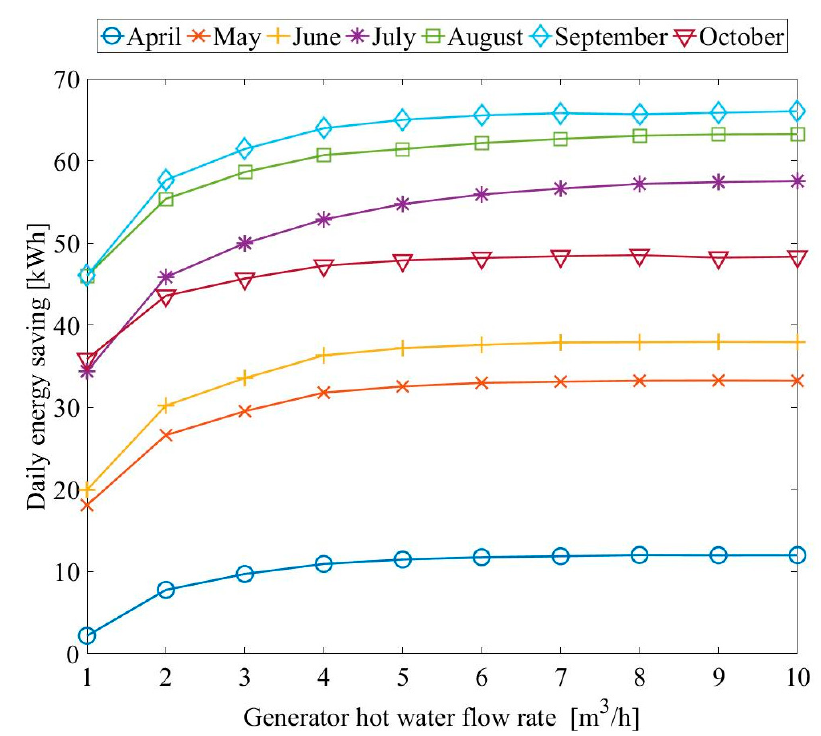
Figure 11. Daily energy saving for different generator flow rate based on data from Apr to Oct.